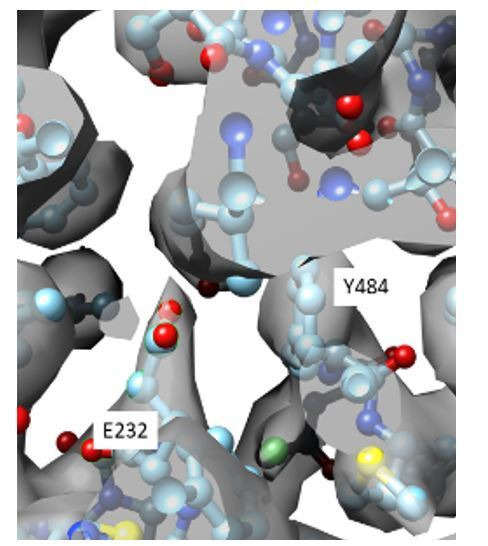
Close up view of the density map (gray) in the CLC-1 pore allows placement of the E232 side chain (cyan, ball and stick).